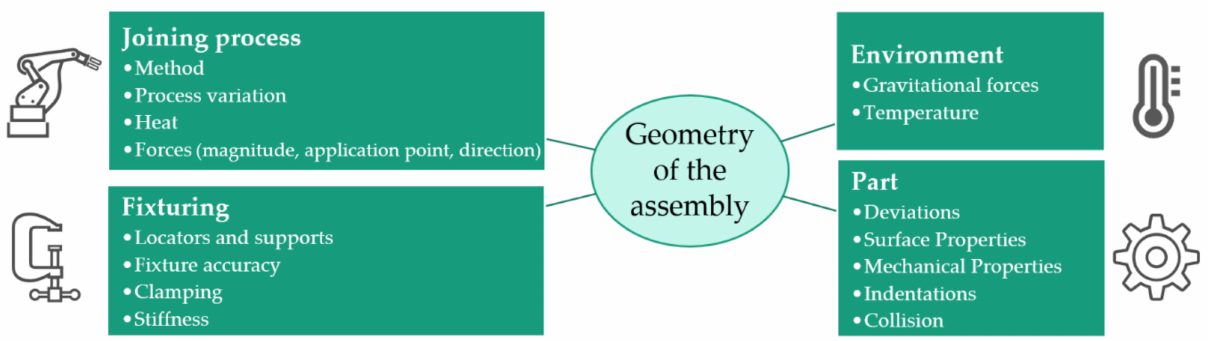
Figure 4. Influence quantities on the geometrical quality of an assembly referring to